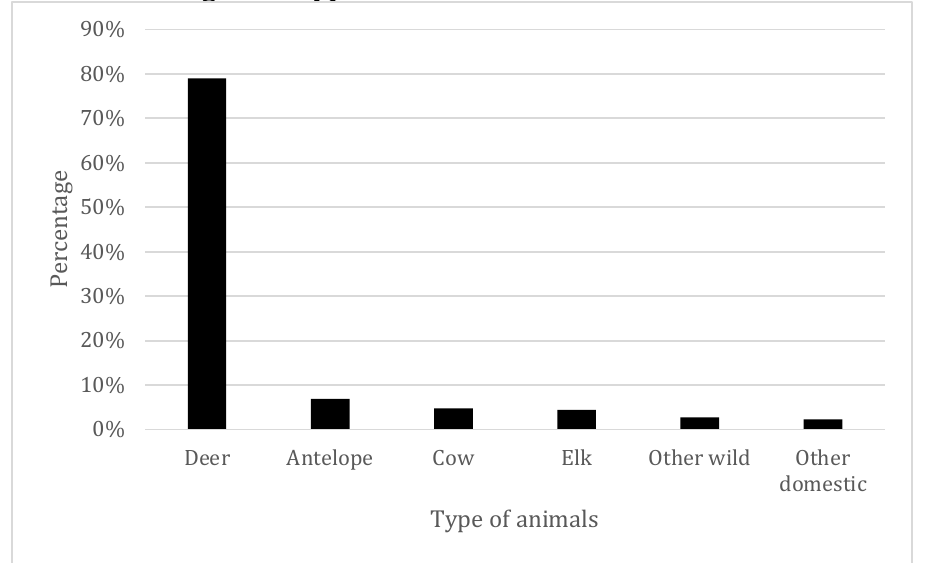
Figure 2: Type of animals involved in crashes